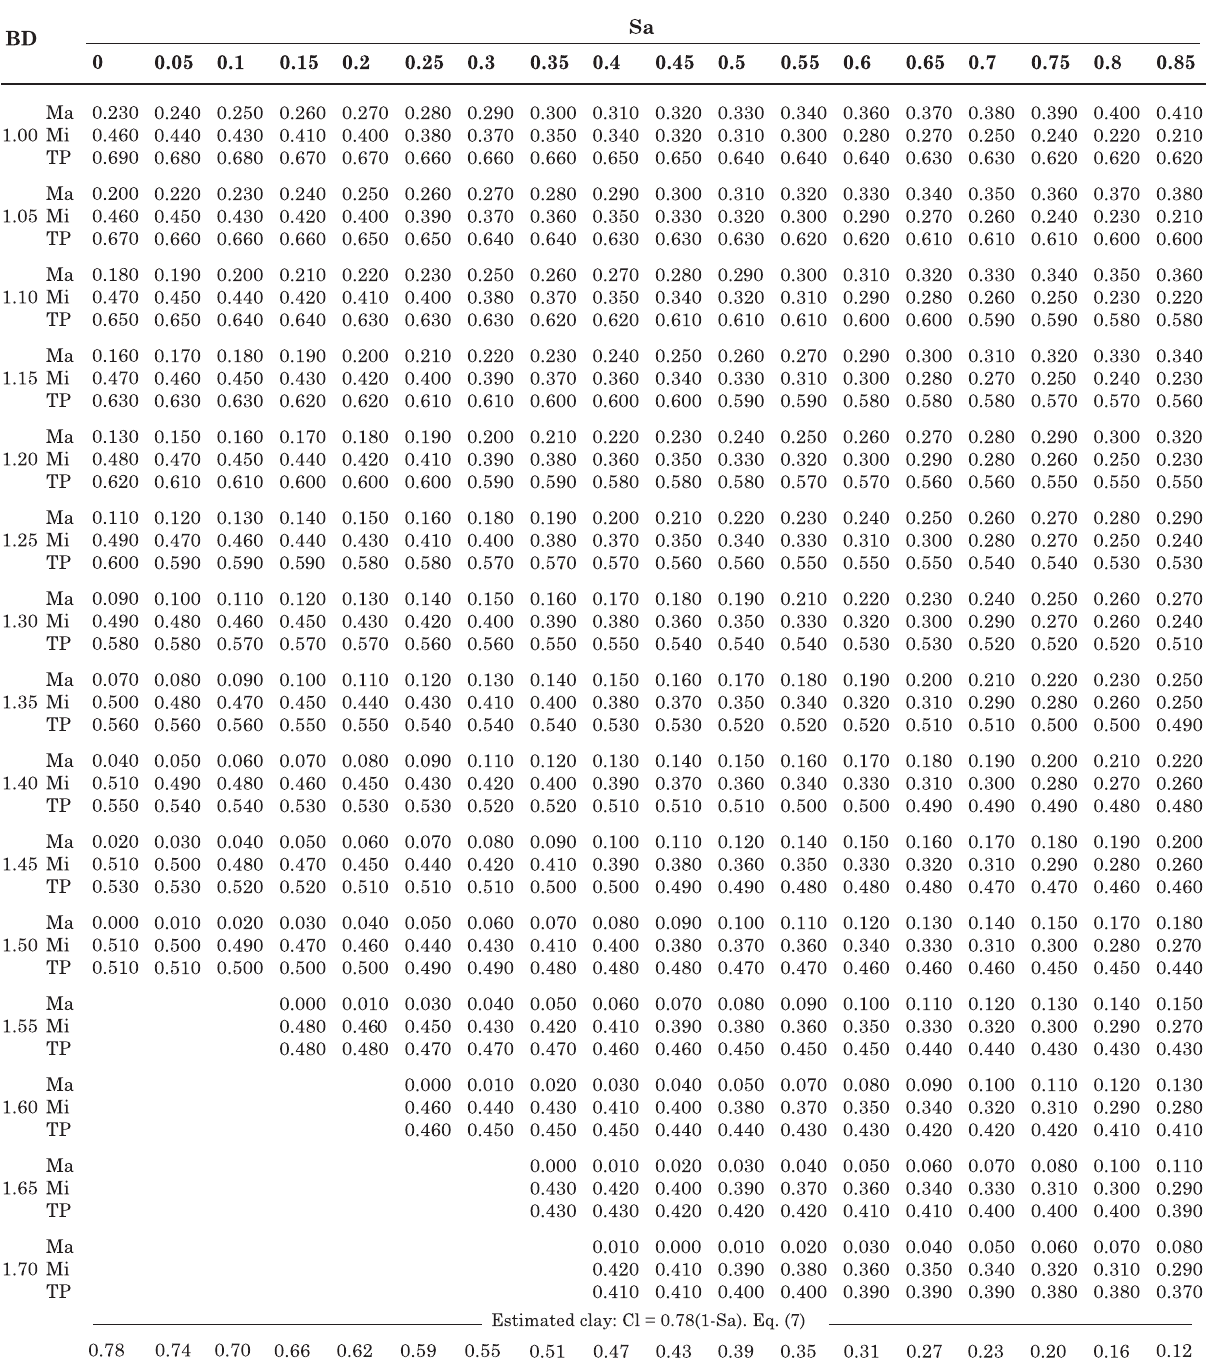
Table 4. Abacus for the estimation of macroporosity (Ma), microporosity (Mi) and total porosity (TP) based on bulk density (BD) and sand content (Sa), according to model 2. Obs.: empty cells represent regions where the model is not